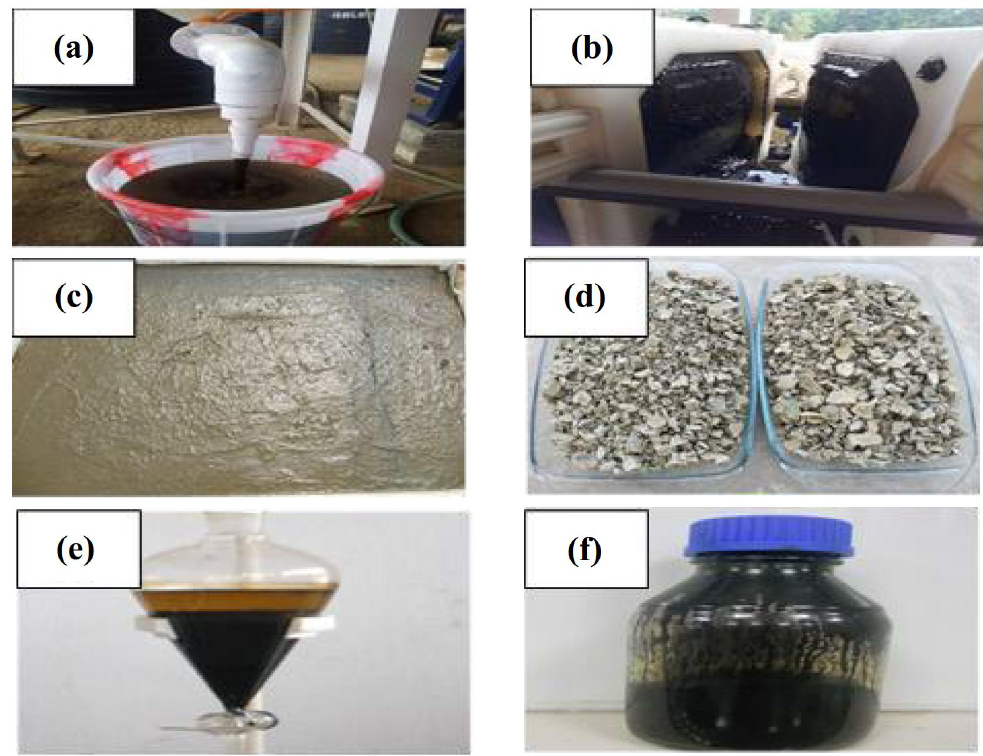
Figure 4. ( a ) Culture collection of clarifier. ( b ) Filter press. ( c ) Fresh biomass under sun dried. ( d ) Dry biomass. ( e ) Separated for bio-crude. ( f ) Bio-crude oil.